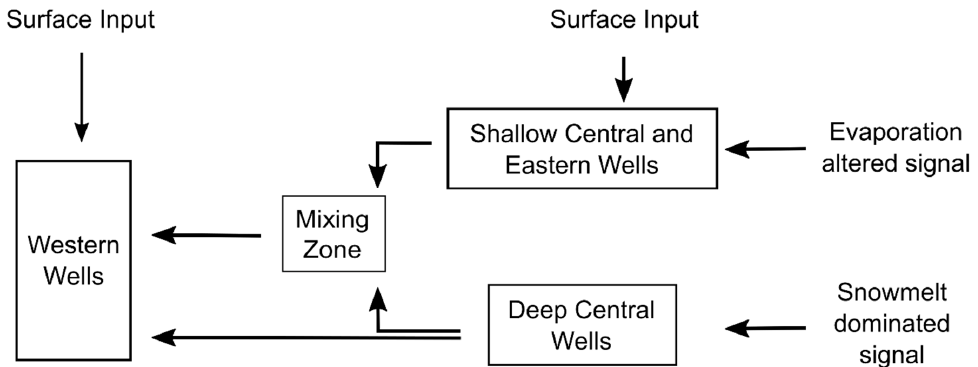
Figure 7. Representation of water sources, subsystems and flow paths through the aquifer system in the South Fork Palouse River Basin.